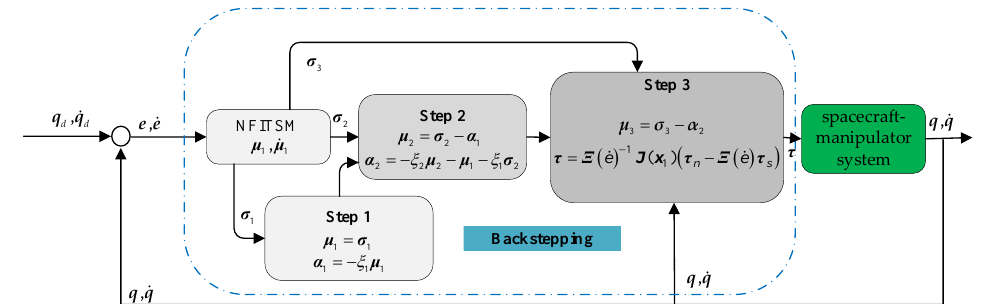
Figure 4. The block diagram of the developed controller.